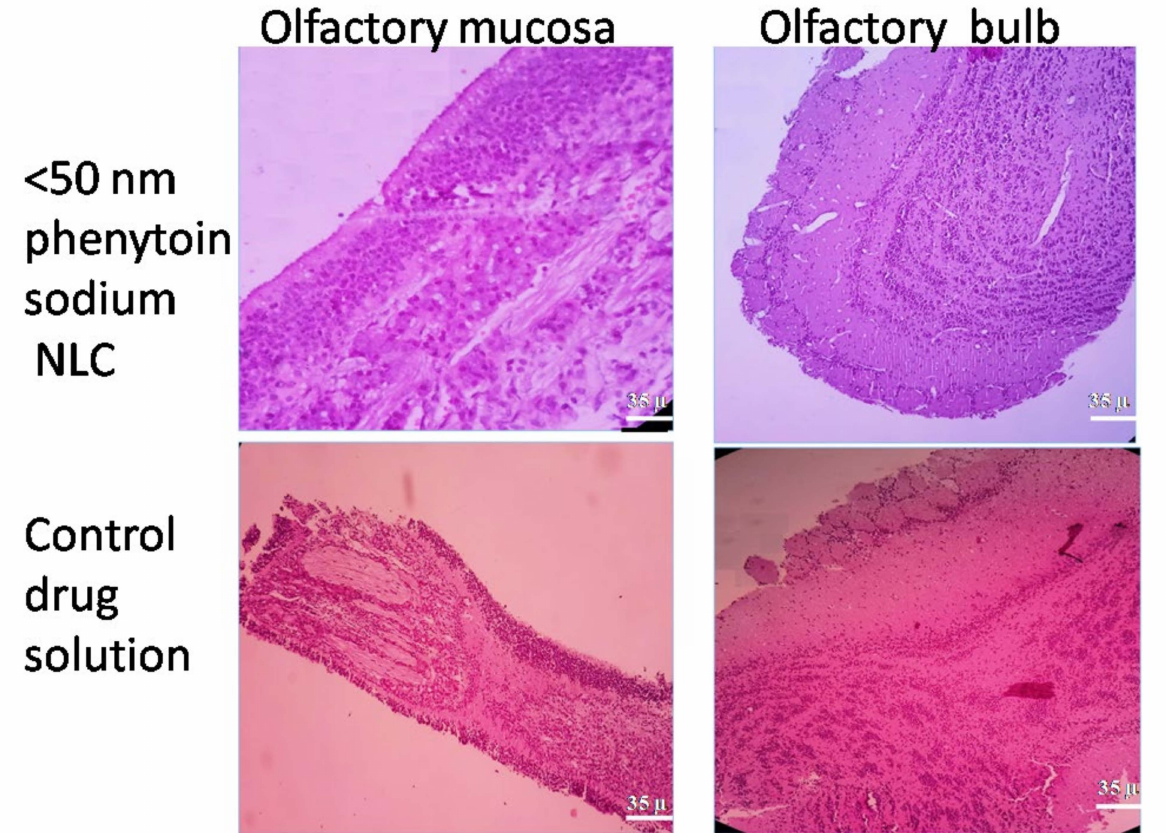
Figure 11. Histopathology images of rat’s nasal olfactory mucosa and olfactory bulb after treatment with <50 nm sized phenytoin sodium NLC as well as control drug